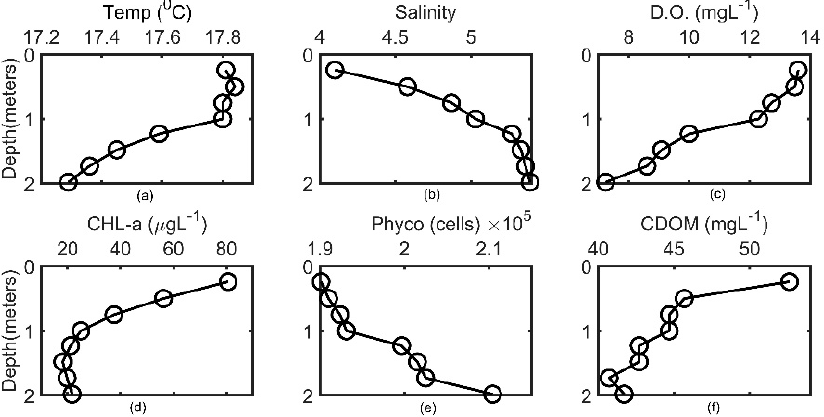
Figure 4. Spring vertical profiles in triblets of the South River Estuary, Beards Creek Triblet. ( a ) Temperature is well mixed. ( b ) Salinity indicates a weak halocline. ( c ) Surface DO supersaturated due to high winds and the spring bloom. ( d ) Chlorophyll ‐ a concentrations are indicative of a spring bloom. ( e ) Phycoerythrin is inversely low compared to chlorophyll ‐ a but still shows concentrations of blue ‐ green algae. ( f ) CDOM concentrations are high at the surface (1 m).